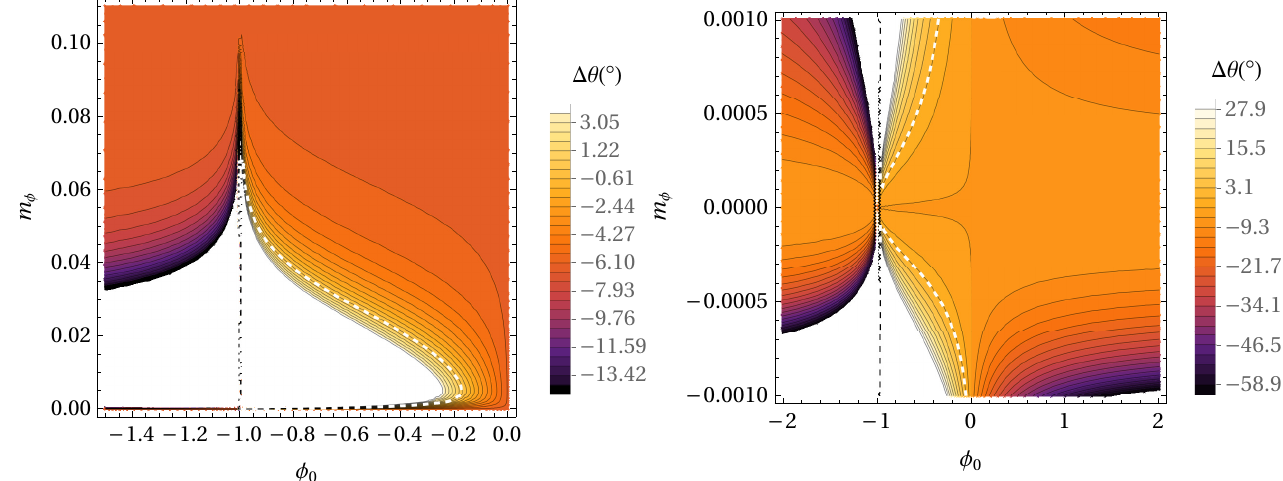
Figure 2. The same as in Figure 1 but for the values of the mass density distribution of extended matter ρ 0 = 4 × 10 8 M (cid:12) pc − 3 . The right panel represents the same as the left panel but for smaller values of the m φ